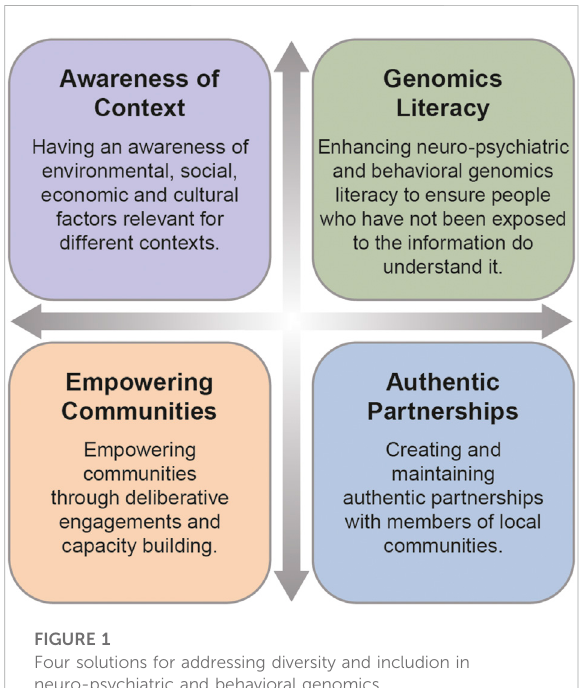
FIGURE 1 Four solutions for addressing diversity and includion in neuro-psychiatric and behavioral